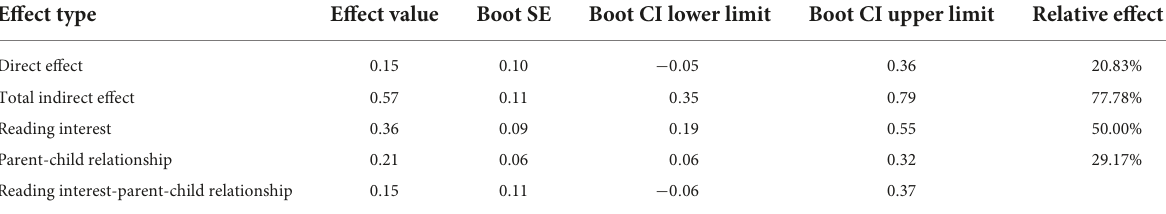
TABLE 4 Analysis of the mediation effects of reading interest and parent-child